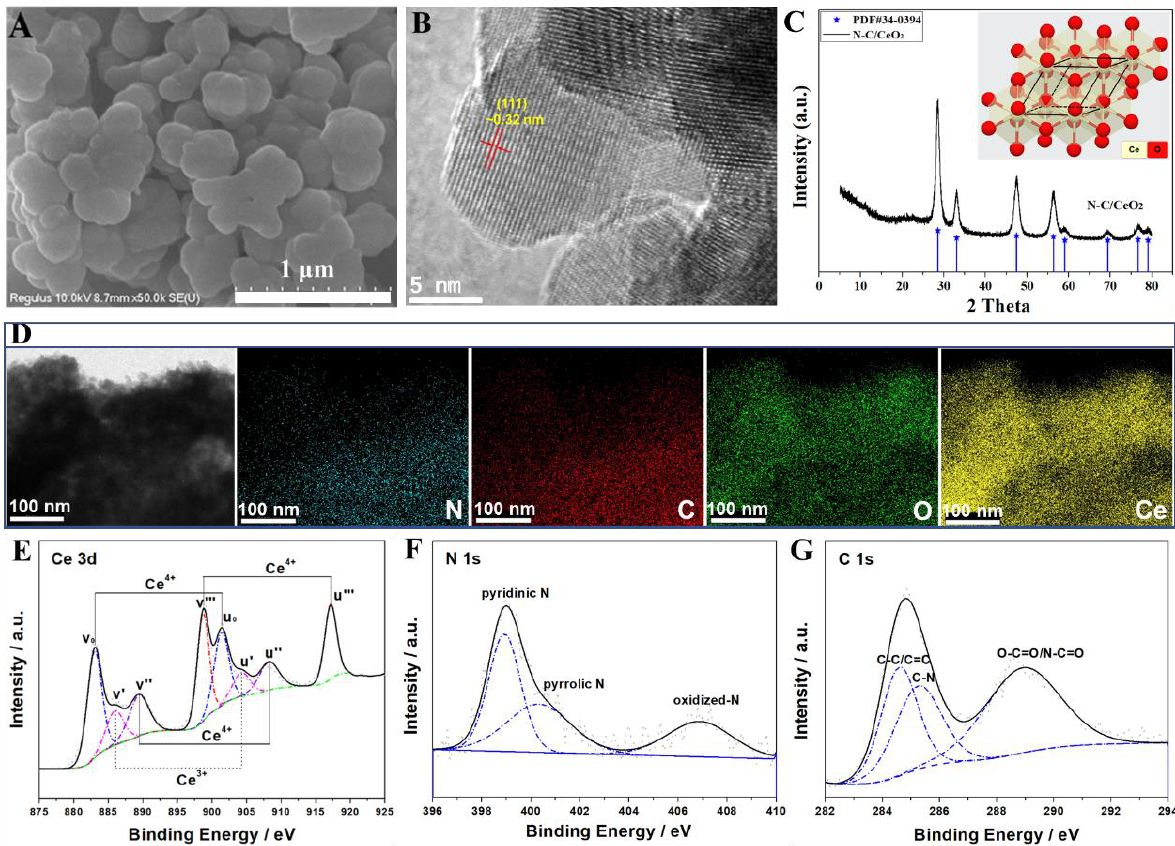
Figure 1. ( A ) SEM image; ( B ) HRTEM image; ( C ) XRD pattern of N-C/CeO 2 composite and the standard PDF cards of CeO 2 , inset: crystal structure of CeO 2 ; ( D ) STEM-mapping and XPS pattern of N-C/CeO 2 composite; ( E ) Ce 3d; ( F ) N 1s; ( G ) C 1s.